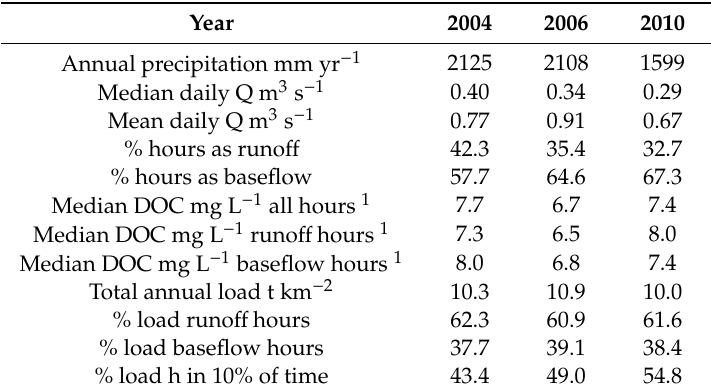
Table 1. Summary data for the three study years for the Glenamong